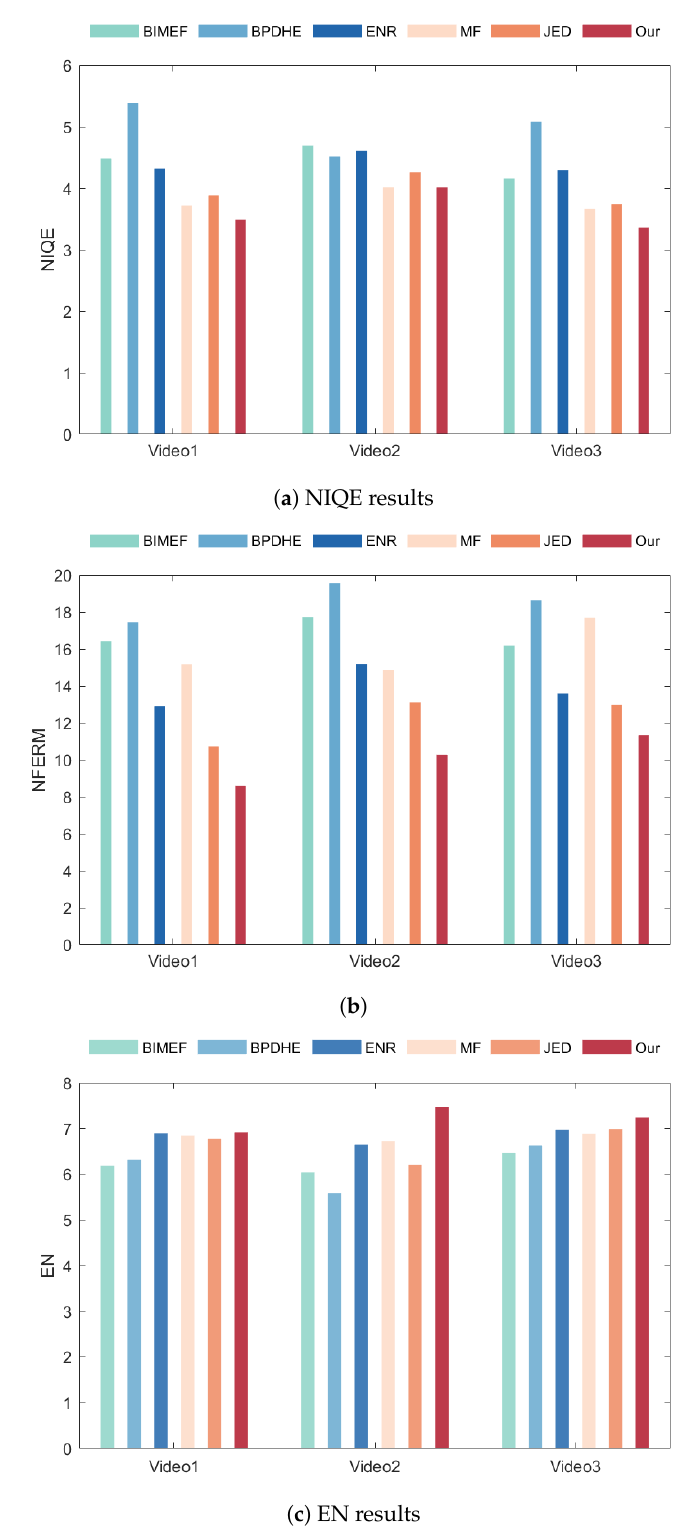
Figure 14. Quantitative comparisons of the three metrics, i.e., NIQE, NFERM, and EN, on Video 1 (containing the Align 700L V2 obstacle object), Video 2 (containing the DJI F450 obstacle object), and Video 3 (containing the DJI Mavic 2 Pro obstacle object). The six algorithms were selected for comparison. The lower the NIQE and NFERM, the better the performance. The higher the EN, the better the performance. ( a ) NIQE results. ( b ) NFERM results. ( c ) EN